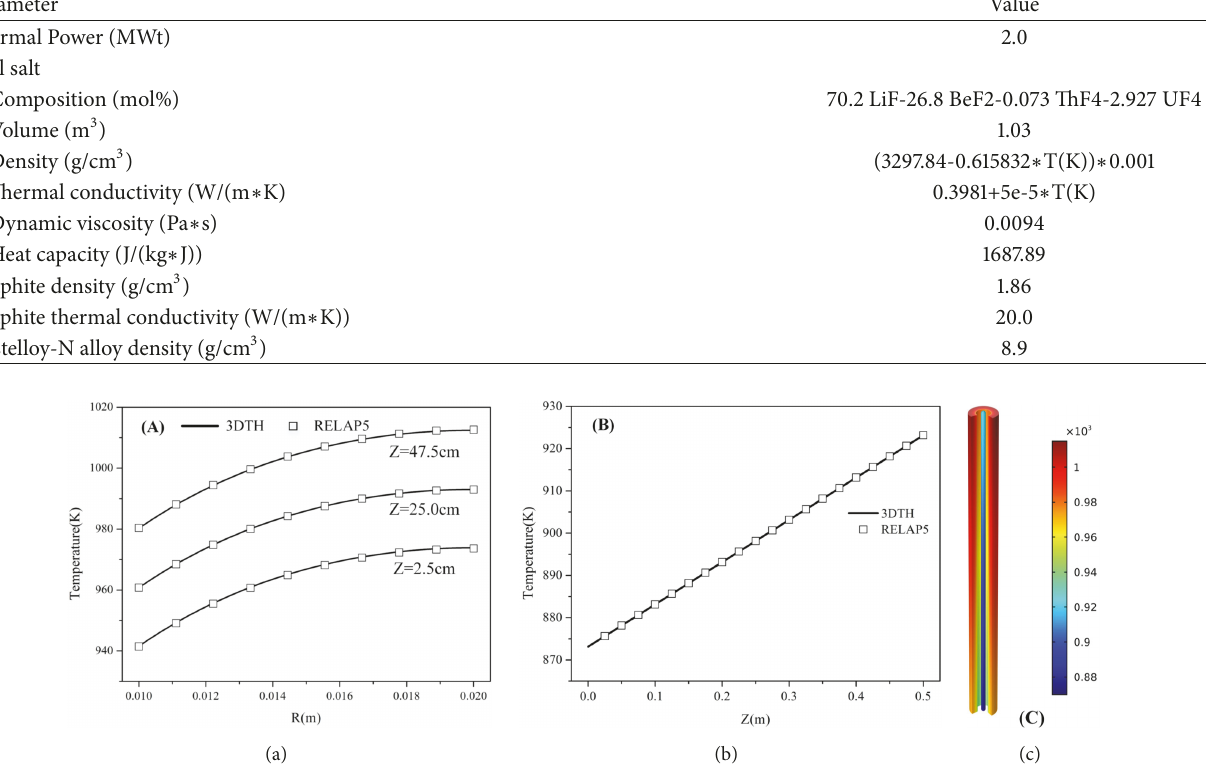
Figure 2: The temperature distribution in the pipe. (a) The radial temperature distribution in the tube wall (line represents the 3DTH and square represents the RELAP5). (b) Coolant temperature distribution along the axial direction (line represents the 3DTH and square represents the RELAP5). (c) The temperature profile of the pipe (unit: K).